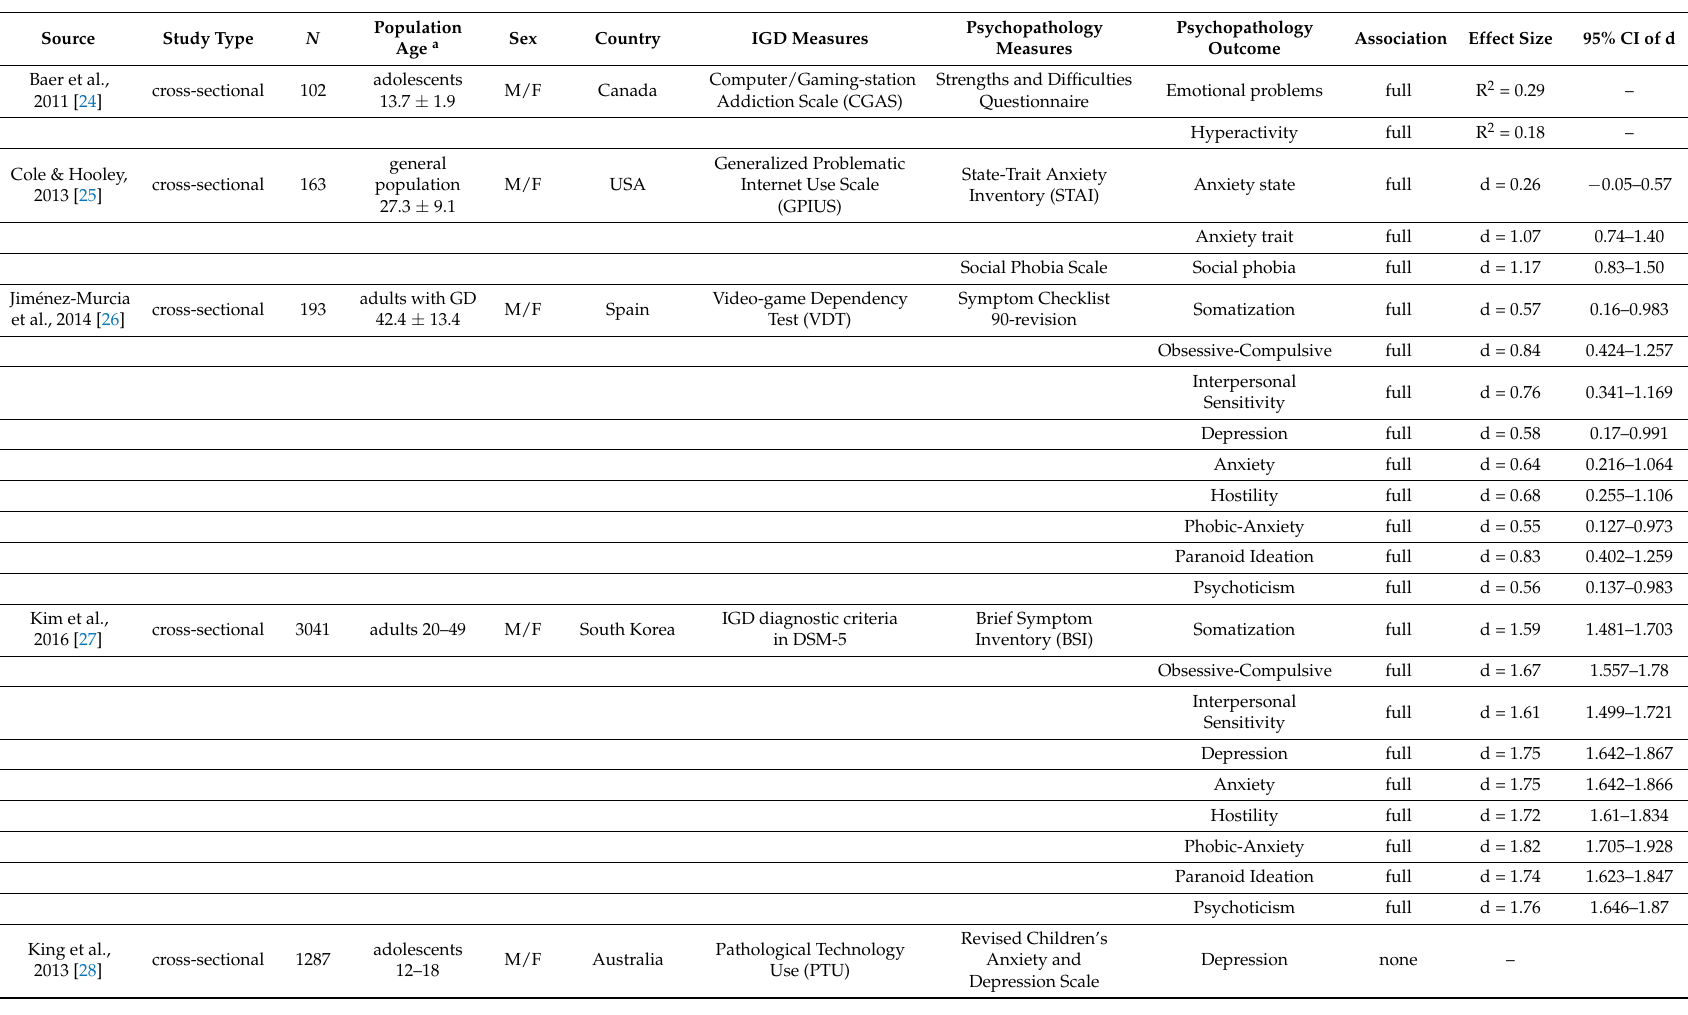
Table 1. Studies examining the relationship between Internet Gaming Disorder (IGD) and comorbid psychopathology, including effect